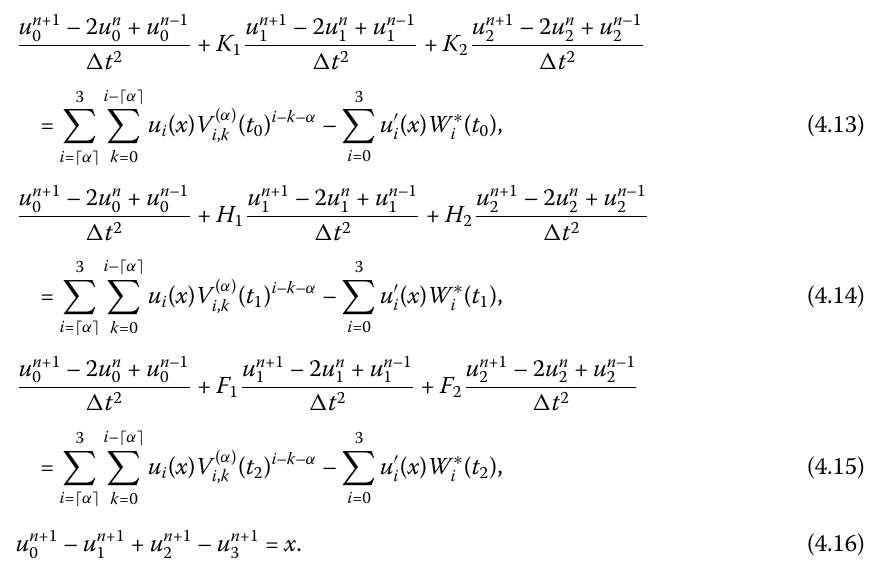
Graphs and Table : In Fig. 1, the numerical solutions attained for Example 4.1 using the shifted Chebyshev collocation method are presented and are compared with the previous method [7] and with the exact solution as well. And it is easy to observe, the proposed method has an excellent agreement with the exact solution. Table 1 presents the numerical results of Example 4.1 at various levels of value of α